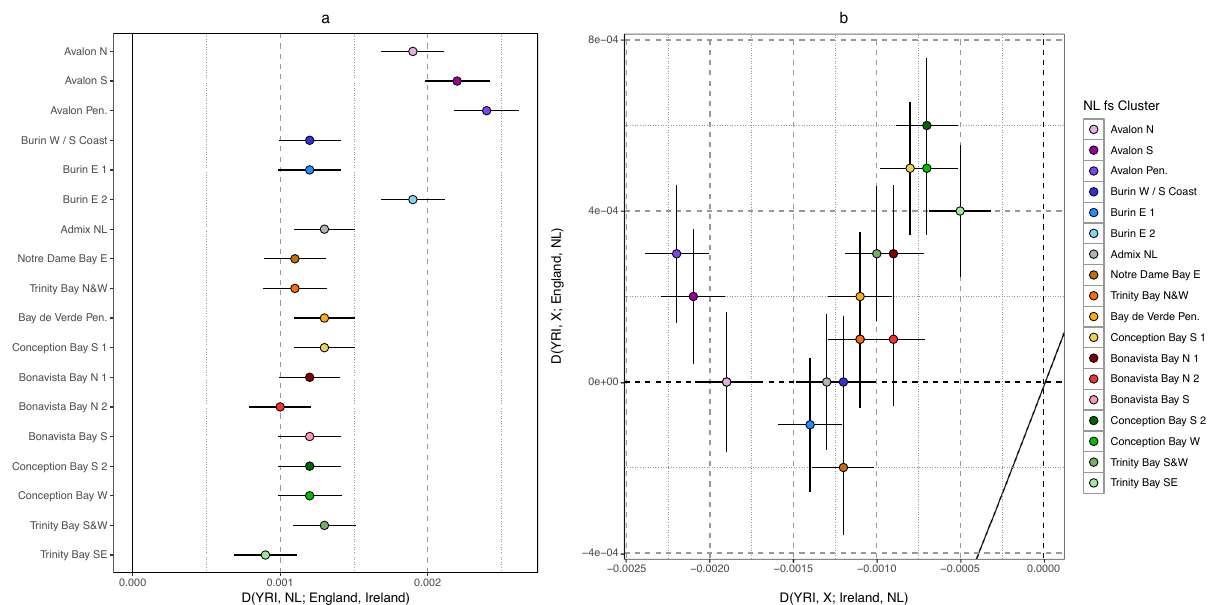
Fig. 5 Evidence of NL speci fi c genetic drift from Irish and English source. a Patterson ’ s D statistic 43 testing the allele sharing between NL clusters and English and Irish population references. Positive values indicate excess sharing within NL clusters to Ireland, and negative indicate excess sharing to England. YRI indicates the outgroup for these tests (Yoruban sampled in the 1000 Genomes Project Phase 3). b Testing NL-speci fi c drift with Patterson ’ s D statistic. X-axis tests if each NL cluster presents an excess of Irish (negative D value) or NL (positive D value) alleles, and Y axis tests if each NL cluster presents an excess of English (negative D value) or NL (positive D value) alleles. All panels were plotted using the statistical computing language R 63 and the package ggplot2, with error bars showing 1 standard